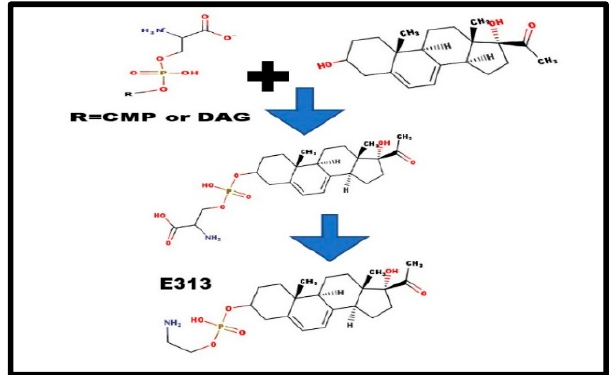
Figure 4. Formation of steroid phosphoethanolamine diesters.